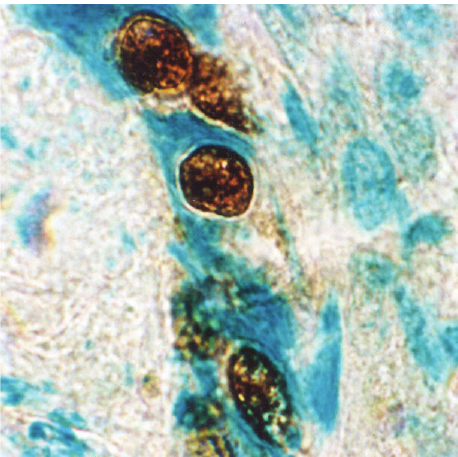
Figure 2: p53 immunostaining in malignant cells from an invasive (ductal) breast carcinoma. Immunoreactivity specific for p53 was detected in the tumor cell nuclei. Perinuclear p53 immunolocal- ization is evident. Tumor cell nuclei were more frequently ball-like shaped or displayed an elliptic shape. Sequestered p53 localizes to large aggregates in the cytoplasm (avidin-biotin immunoperoxidase technique with mAb DO-7, counterstained with methyl green, × 320).